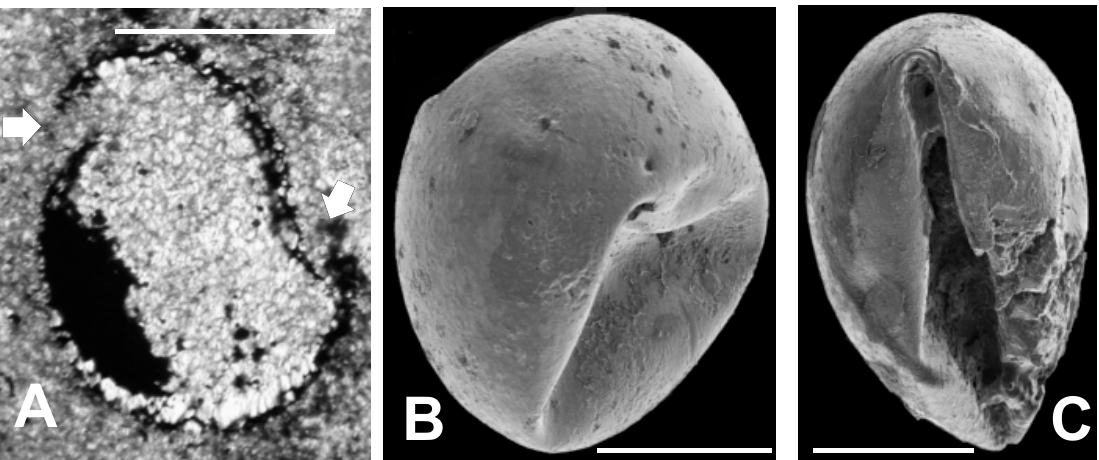
Figure 10. Deformed specimens. Scale bar in A, B, and C = 100 µm. ( A ) Thin section of a specimen (TYT-11) with a portion of the body wall split away from the main body. The fragment has an inwardly convex curvature; ( B ) SEM image of a sphaeromorphic specimen (TYS-15) with an inwardly convex depression in its body wall; ( C ) SEM image of a sphaeromorphic specimen (TYS-04) with a sharp, crease-like fold in its body wall.